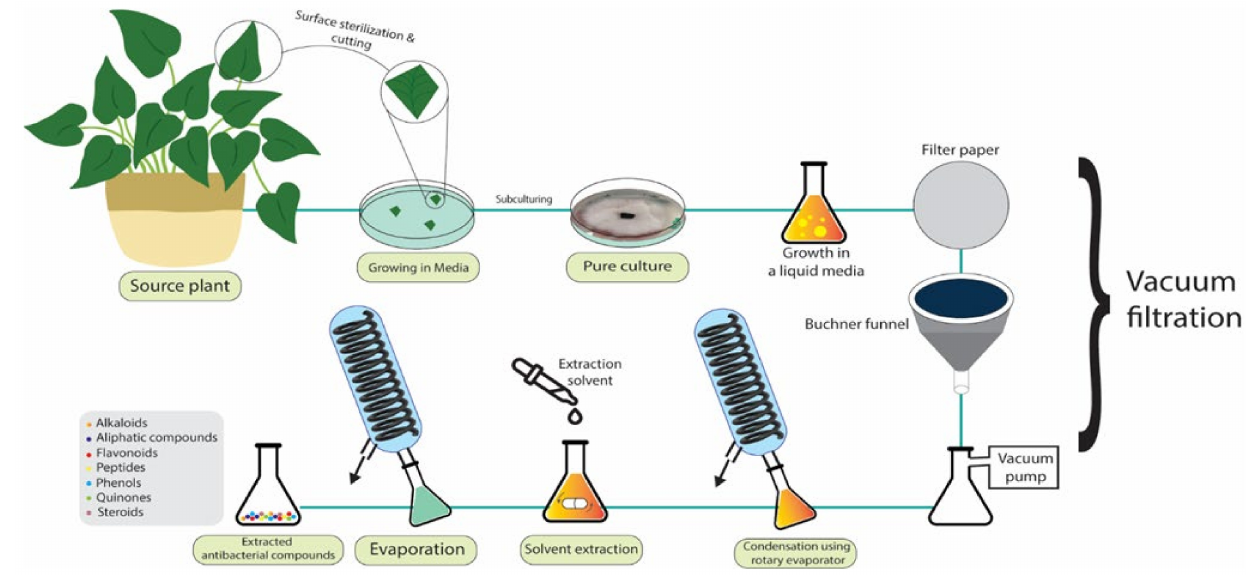
Figure 11. Extraction process of antibacterial compounds from